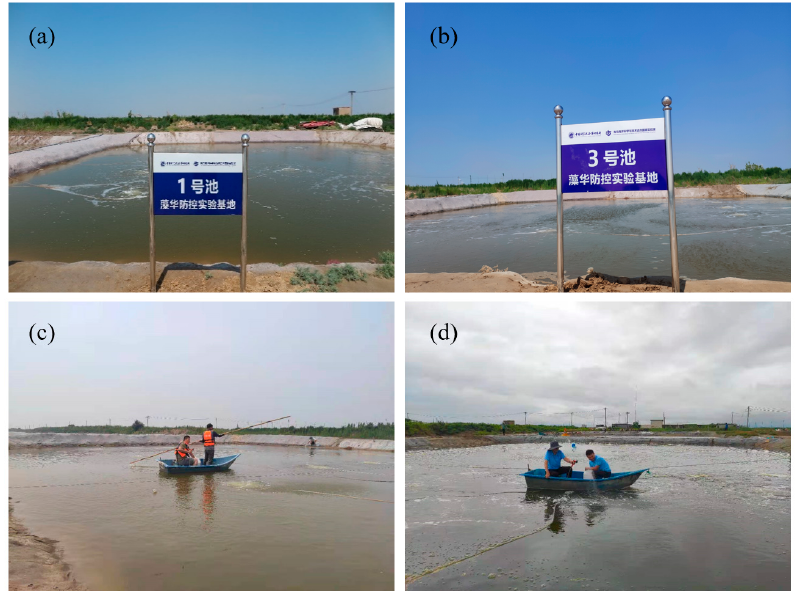
Figure 1. Field photos of control pond ( a ), MC-treated pond ( b ), and on-site operation of MC ( c , d ).